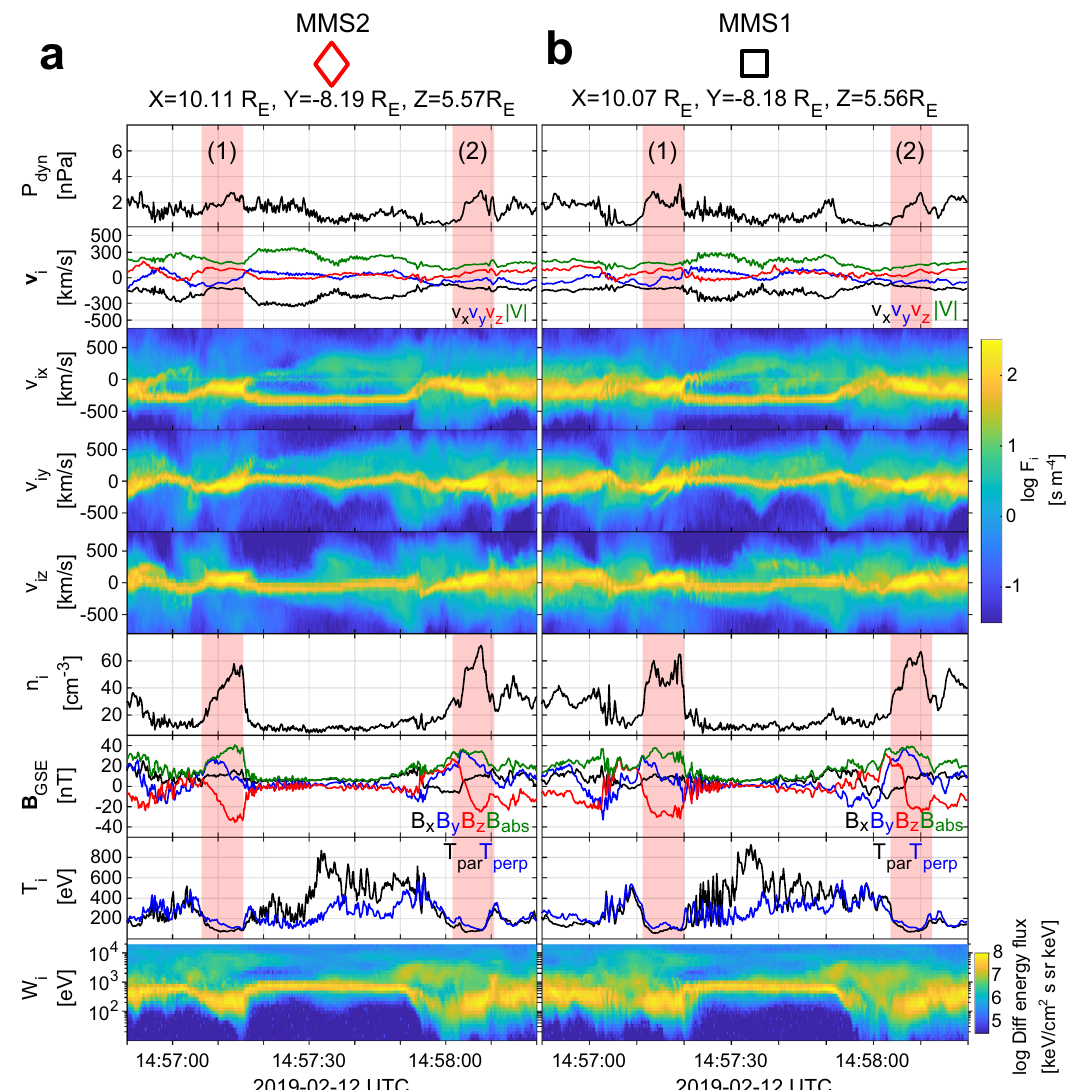
Fig. 2 Spacecraft position and overview of the measurements for Magnetosphere Multiscale (MMS) 2 and 1. a , b Overview observations in Geocentric Solar Ecliptic (GSE) coordinates of the 2 outermost MMS spacecraft ordered by distance to the Earth (MMS2 - red diamond, MMS1 - black square). From top to bottom, ion dynamic pressure, ion bulk velocity fl ow, v x , v y , v z 1D reduced ion velocity distribution functions (VDFs), ion number density, magnetic fi eld, ion temperature, and ion differential energy fl ux spectrum. Sequentially observed shock fronts are numbered and marked with red-shaded